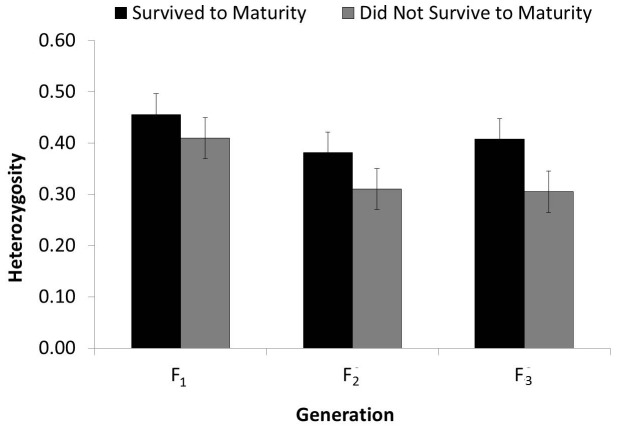
Heterozygosity was significantly higher in captive tree snails of Achatinella lila surviving to maturity in the third generation, but not the first or second.